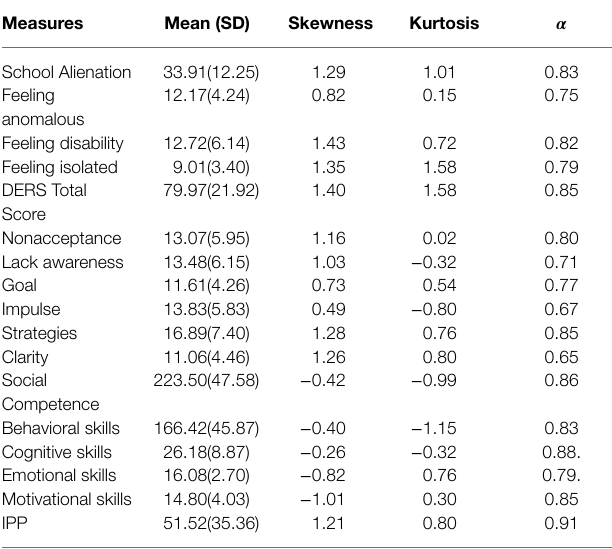
TABLE 1 | Descriptive statistics for study variables ( n =